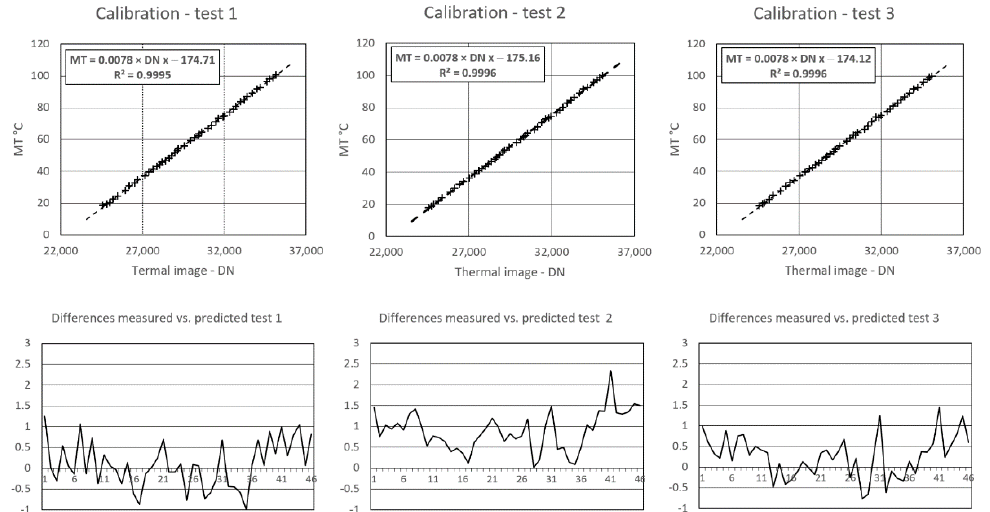
Figure 4. Radiometric calibration of the E10T camera obtained using the heated base of the Omni3d Factory 1.0 printer. The upper part of the illustration shows the relationship between the temperature measured on the surface of the heated base and the DN values read on the thermal images. In the lower part of the figure, the difference between the measured temperature and the one estimated using the established dependence is presented.